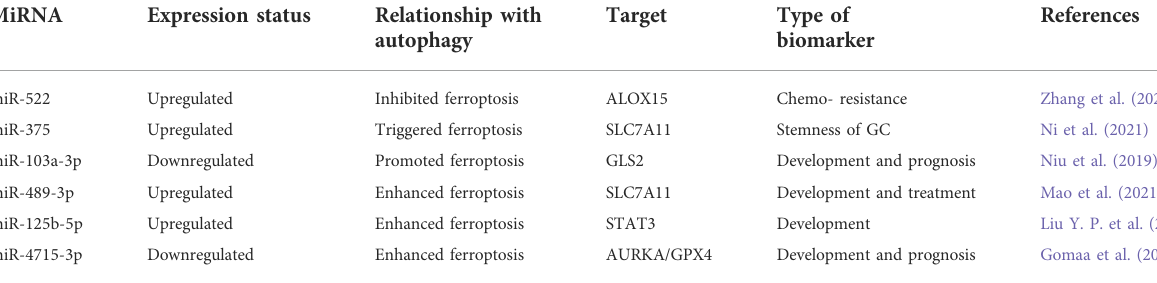
TABLE 1 Overview of the role of ferroptosis-related miRNAs in GC.